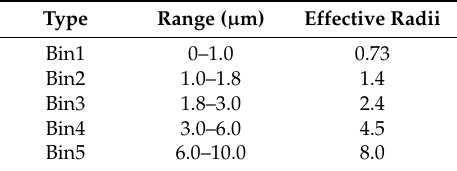
Table 2. Weather Research and Forecasting model coupled with chemistry (WRF-Chem) dust size